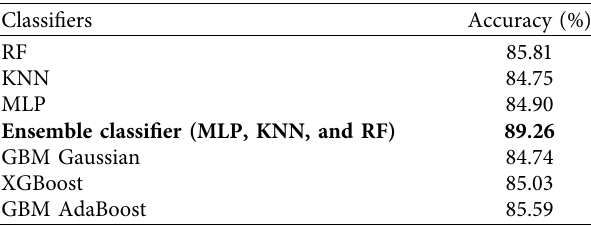
Table 6: Classification results using top 10 features selected by Chi- square.